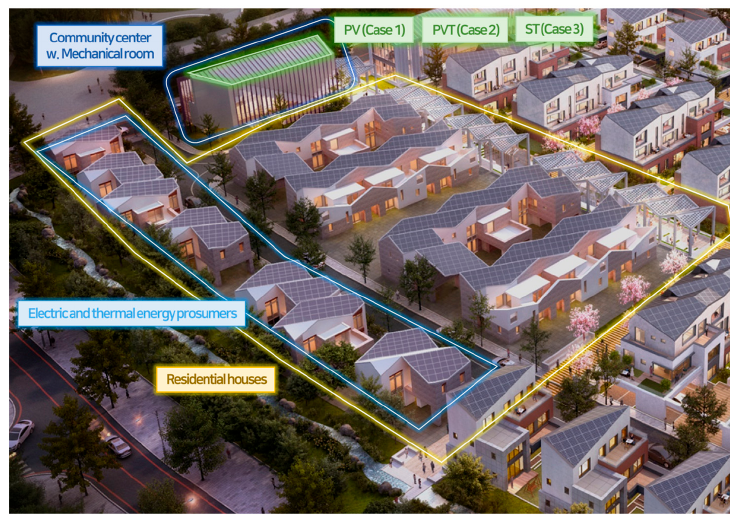
Figure 2. Overview of the smart village [22].